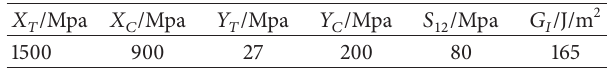
Table 2: Failure strengths of E-glass/Ly556/HT907/DY063